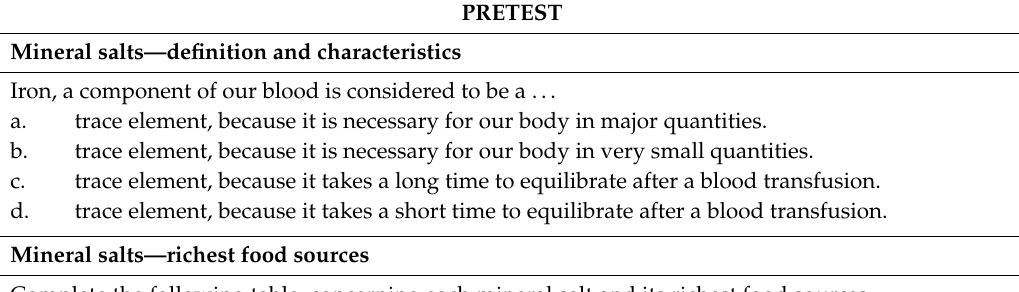
Table 2. Examples of questions used in pre- and post-tests for three of the studied